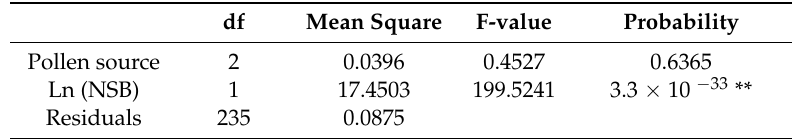
Table 5. Results of ANCOVA determining the differences in the adjusted BW among the pollen sources in the 2015 experiment without self-pollination. df Mean Square F-value